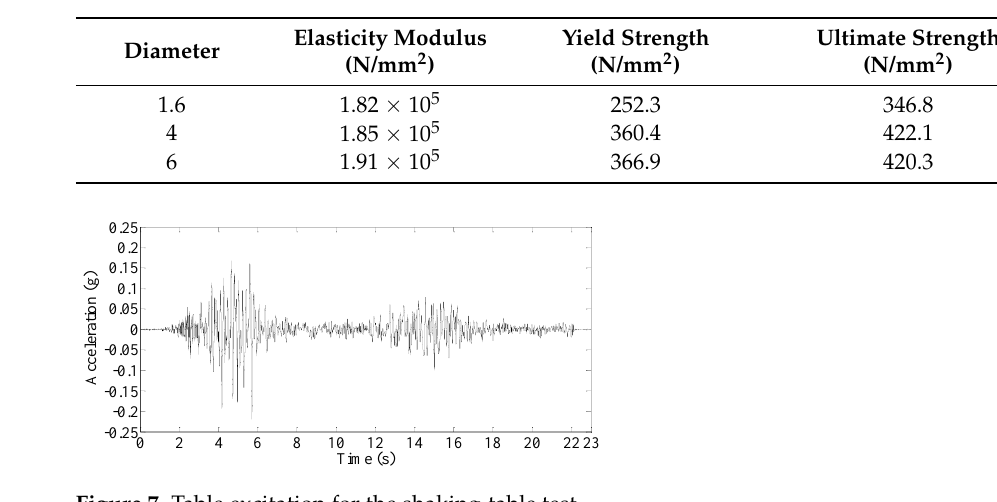
Figure 6. Shaking-table test model for four-story, infilled RC-planar-frame structure. ( a ) Plan view of first floor. ( b ) Plan view of other floors. ( c ) Reinforcement of column. ( d ) Reinforcement of beam. Table 1. Material properties for the reinforced bars.